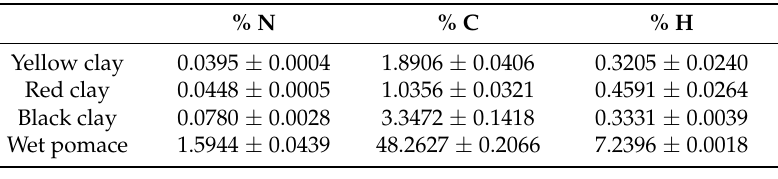
Table 1. Elementary composition of waste and clays.